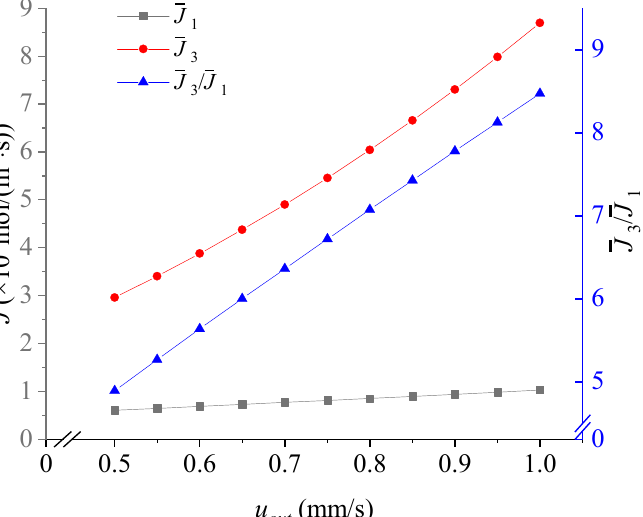
Figure 6. The dependence of the average flux of Li + , the average flux of Mg 2+ and the Mg 2+ /Li + flux ratio on u out . Values of other parameters are: V = 30V T , u 1 = 0.63 mm/s, u 2 =1 mm/s, 18 μ m ≤ y ≤ 31.5 μ m , x = 96 μ m.